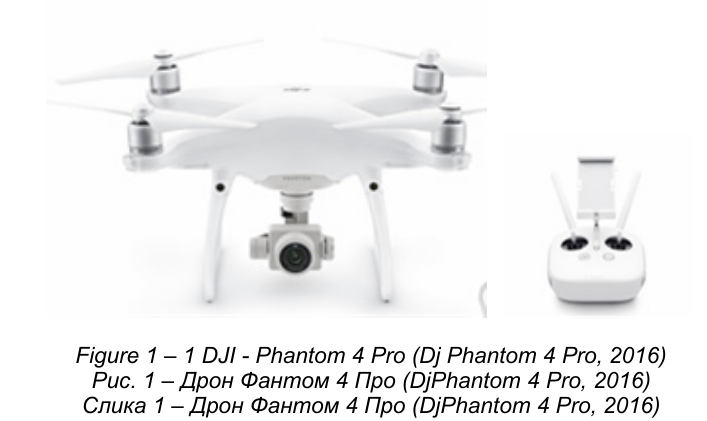
Figure 1 – 1 DJI - Phantom 4 Pro (Dj Phantom 4 Pro, 2016) Рис . 1 – Дрон Фантом 4 Про (DjPhantom 4 Pro, 2016) Слика 1 – Дрон Фантом 4 Про (DjPhantom 4 Pro,